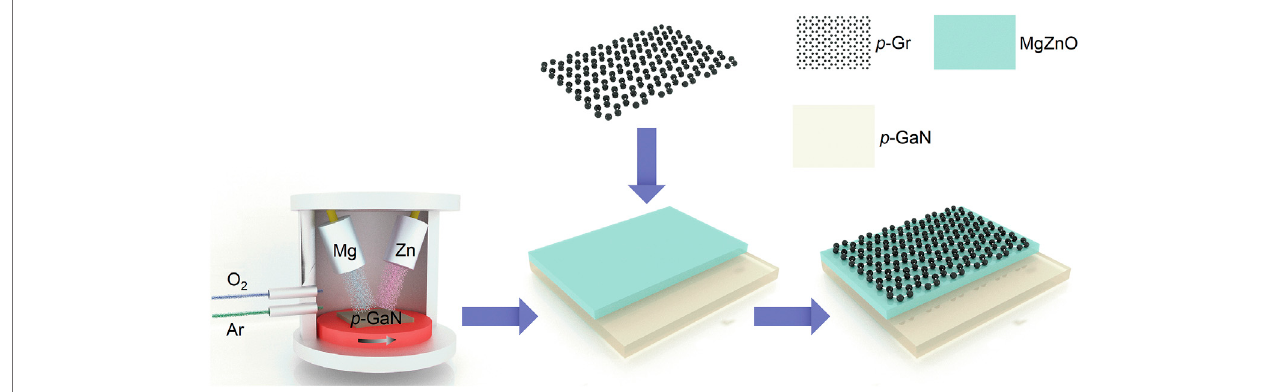
FIGURE 1 | Fabrication process of Gr/MZO/GaN structure. The MZO fi lm is grown fi rst, and then the graphene transfer is performed.